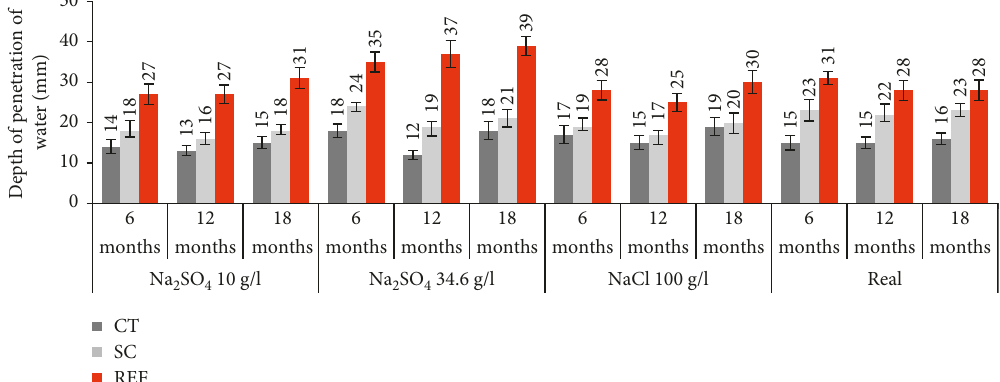
Figure 8: Comparison of depth of penetration of water under pressure in concrete exposed to a liquid aggressive environment and a real environment. The error bars represent the range of measurements for 3 samples.